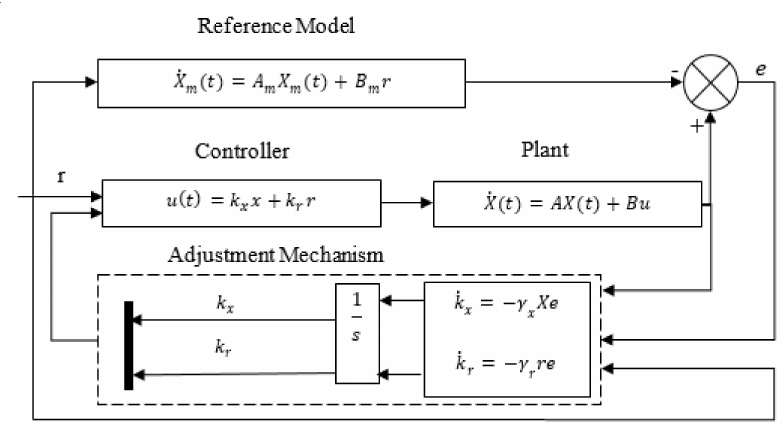
Figure 2. A block diagram of DMRAC (Direct Model Reference Adaptive Control) algorithm.